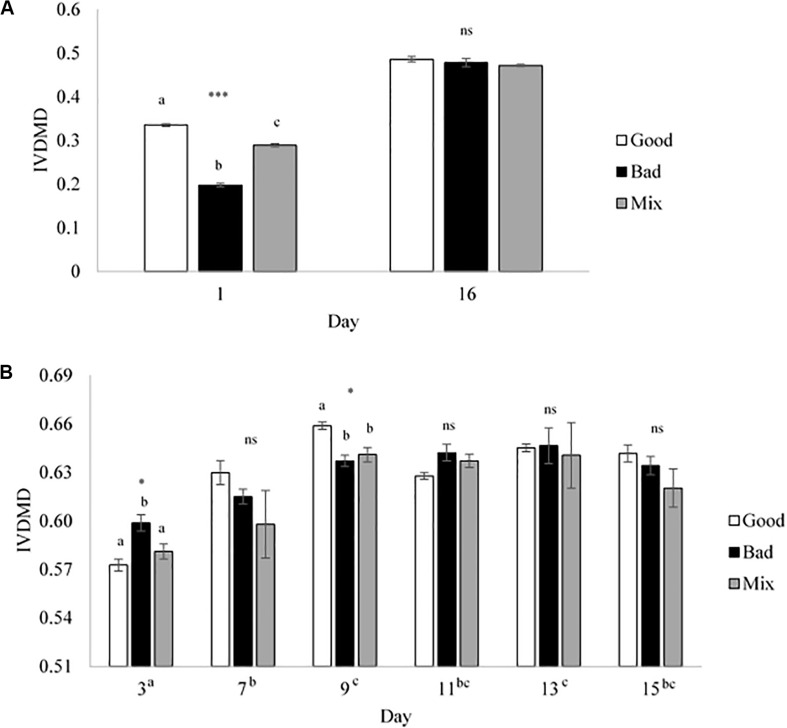
In vitro dry matter disappearance for the Good, Bad, and cross inoculated (1:1 Mix) rumen fluids in Experiment 1. (A) 24 h fermentations (Days 1 and 16) and (B) 48 h fermentations (Days 3, 7, 9, 11, 13, and 15). Bars show the mean value at each time point with standard error bars. Significant differences are shown within day by different superscript letters for (A) and differences between days are shown next to the x-axis day labels in superscript letters for (B). ***P < 0.001, *P < 0.05, ns, no significant difference.